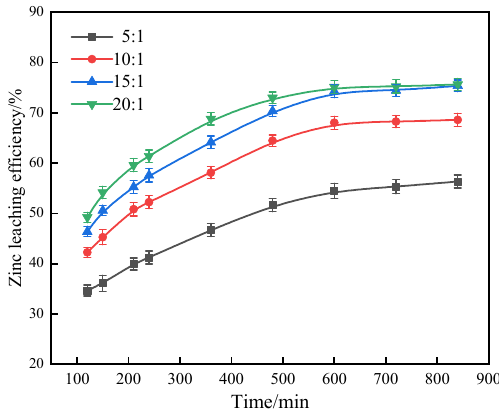
Figure 3. Effect of liquid–solid ratio on the zinc leaching efficiency.